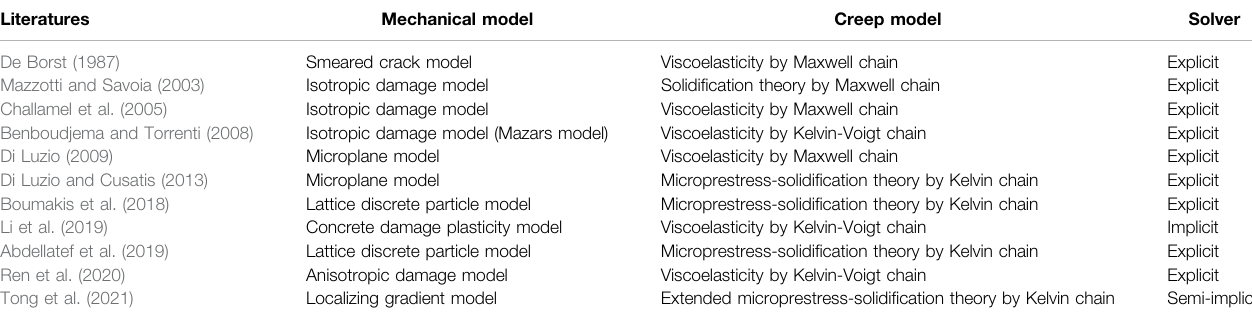
TABLE 1 | Existing researches for the time-dependent damage analyses of concrete